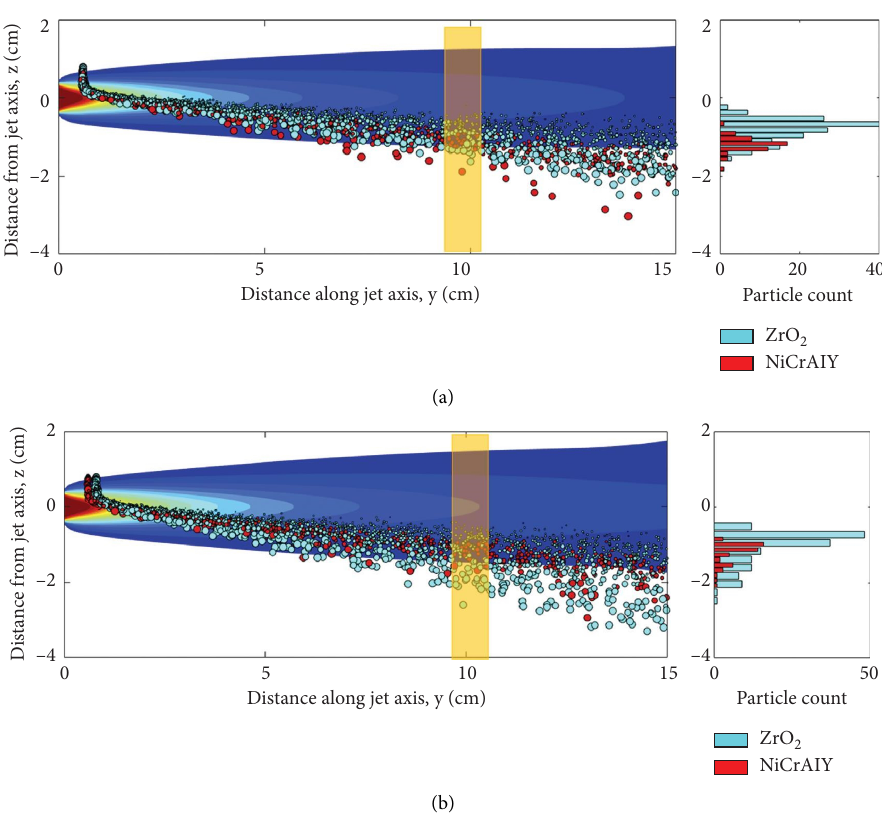
Figure 5: Distributions of the NiCrAlY and the ZrO 2 particles for (a) case AB, and (b) case B4. Te MPSs are measured in the observation window, 9.5 ≤ y ≤ 10.5 cm. For a mass fow rate of 20 g/min for NiCrAlY and ZrO 2 , nearly 886 NiCrAlY and 3181 ZrO 2 particles are in the plasma at any time; the corresponding number of particles in the observation window equal 43 and